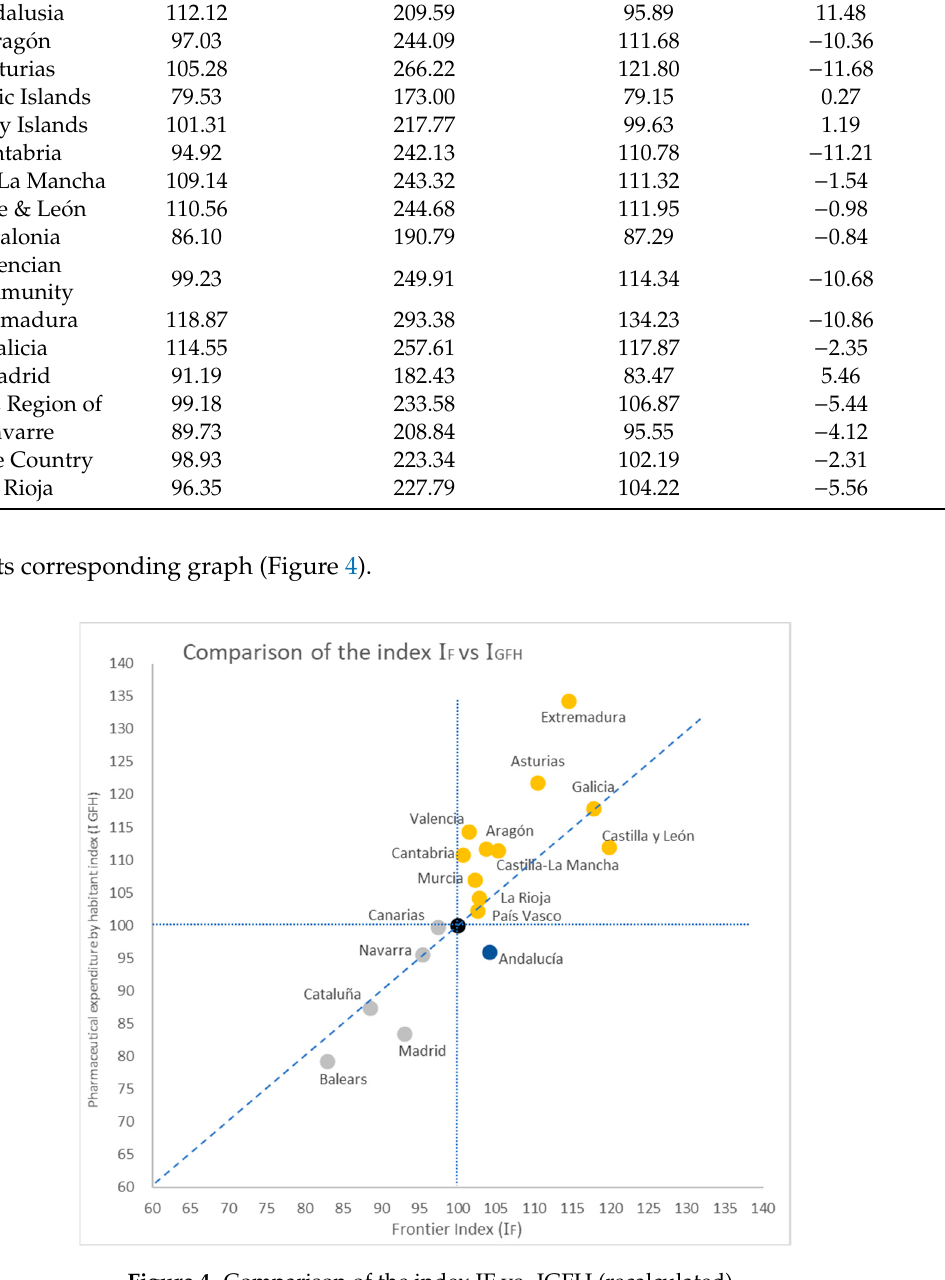
Figure 4. Comparison of the index IF vs. IGFH (recalculated).